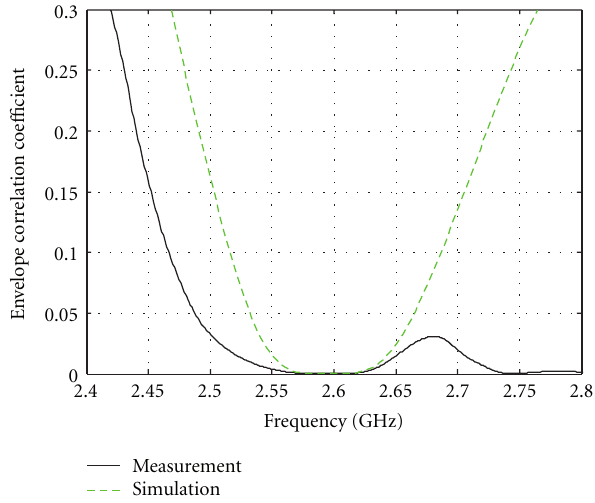
Figure 7: Envelope correlation coe ffi cient of the MIMO antenna system #1 (measurements versus